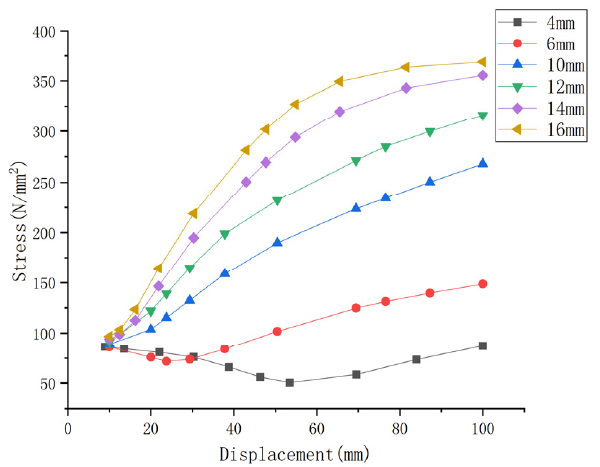
Figure 18. Stress history at C w .